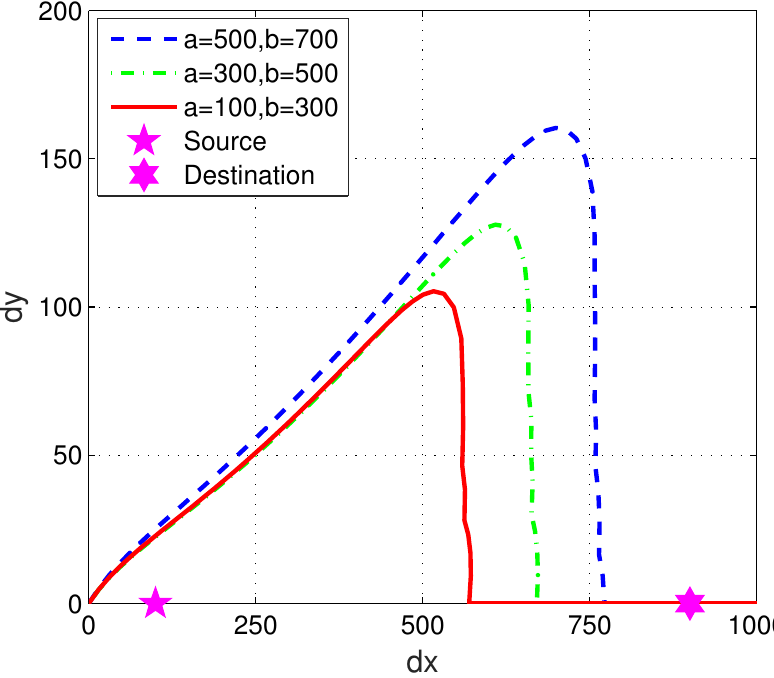
Figure 5. The optimized trajectories for different eavesdropper locations with maximum UAV speed v = 16 m/s and total flight T = 80 s. It is observed that when the eavesdropper location is further away from the destination, the UAV’s optimized trajectory has a shorter total flight distance, which is both spectrum-efficient and